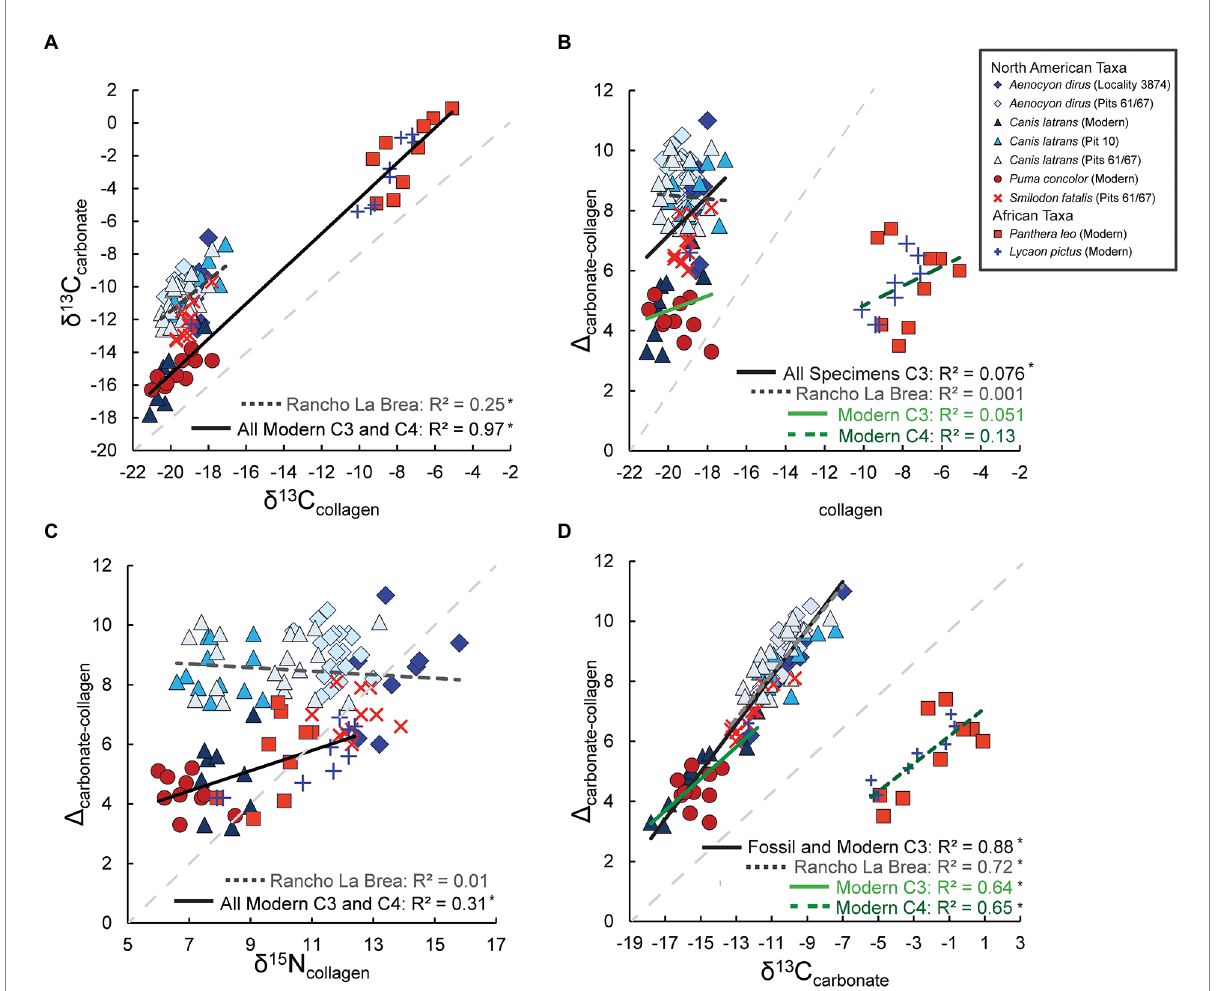
FIGURE 2 Relationship between δ 13 C carbonate and δ 13 C collagen values (A) , and Δ ca-co and δ 13 C collagen values (B) , δ 15 N collagen values (C) , and δ 13 C carbonate values (D ; n = 108). The regression lines and R 2 values correspond to text in the same color and are also noted in Supplementary Table S3. Note, the modern C 3 regression lines in (A) and (B) includes modern North American taxa and one African wild dog with a C 3 value (Supplementary Tables S3, S4 only include geographically similar taxa). The legend in (B) applies to all (A–D) . A light-gray dashed-line with a slope of 1 is present in the background of each panel for reference. *Denotes significant relationships ( p <